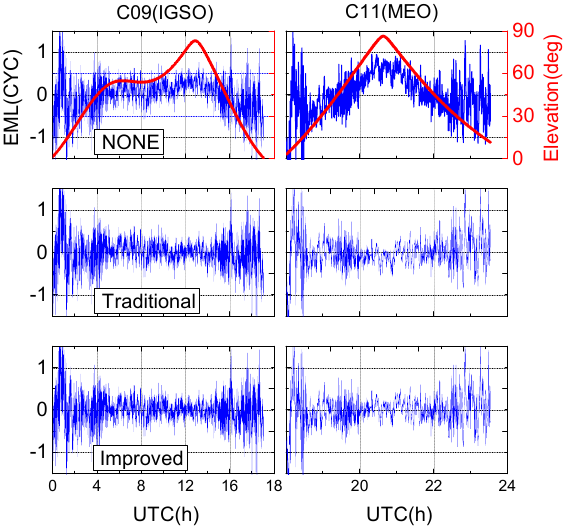
Figure 13. Time series of the derived EWL value on CUT0 (DoY 122/2015).